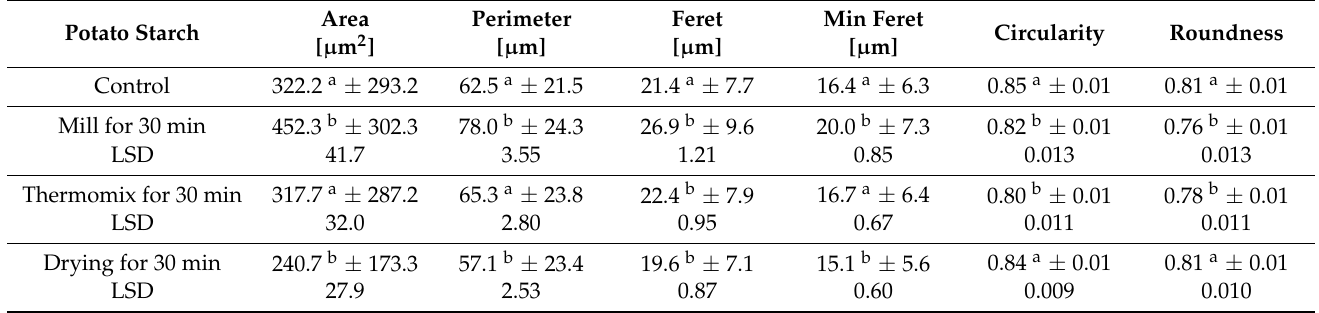
Table 7. Comparison of measurements of potato starch granules before (control) and after grinding and